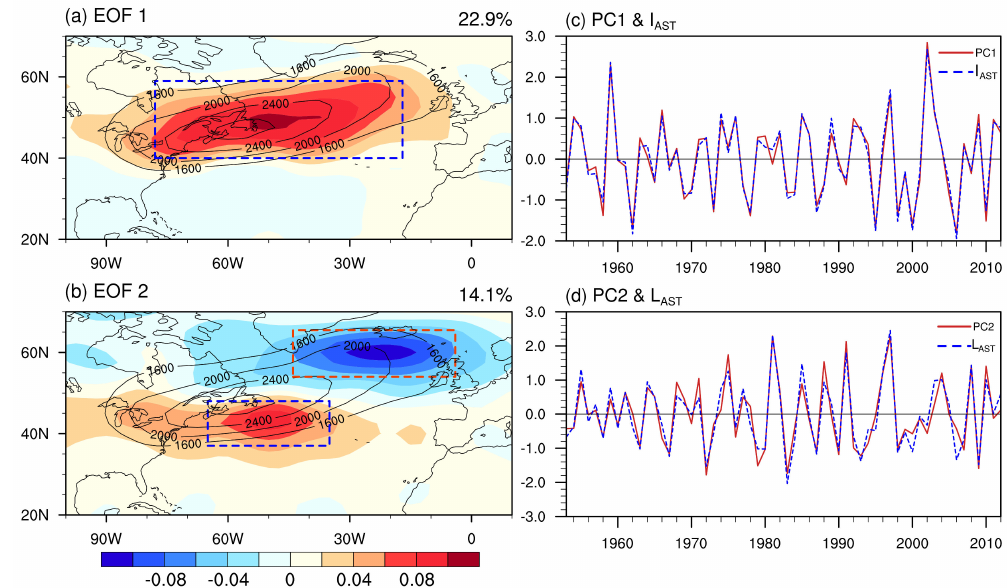
Figure 2. Spatial patterns of ( a ) first and ( b ) second EOF modes of 500-hPa band-pass-filtered geopotential height variance Z (cid:48) 2 (shading; units: m 2 ) in spring during 1953–2012, and corresponding normalized time series (red solid curves) in ( c , d ), respectively. Blue dashed curves in ( c , d ) represent the intensity (I AST ) and location (L AST ) indexes of the AST, respectively. The spring climatological AST (contour; units: m 2 ) is also plotted in ( a , b